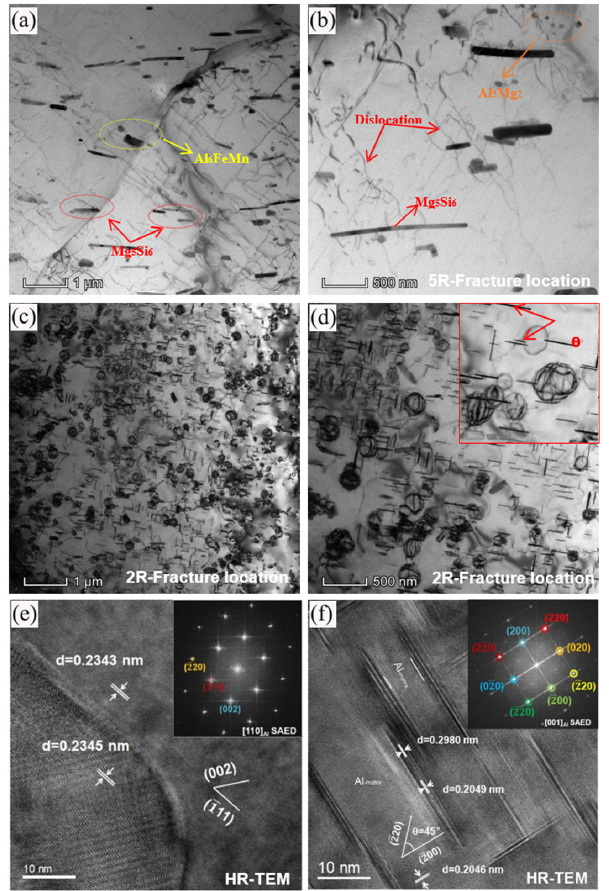
Figure 4. Transmission electron microscopy micrograph of the fracture location in the joint (rotational speed of 800 rpm and welding speed of 100 mm/min): position 1 of 2A5R joint ( a , b ) and position 3 of 5A2R joint ( c , d ) from Figure 2c,d. HR-TEM ( e , f ) correspond to the selected diffraction pattern of ( c , d